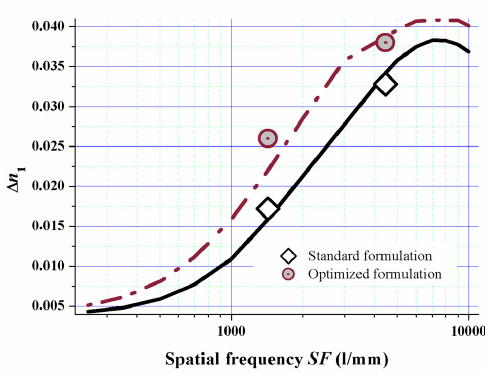
Figure 14. Experimental values of ∆ n 1 (symbols) and simulated ∆ n 1 response versus spatial frequency SF for a standard formulation (solid line) and a formulation with a majority of monofunctional components (dashed line) [51]. The typical error of experimentally determined ∆ n 1 values is about ±0.001.